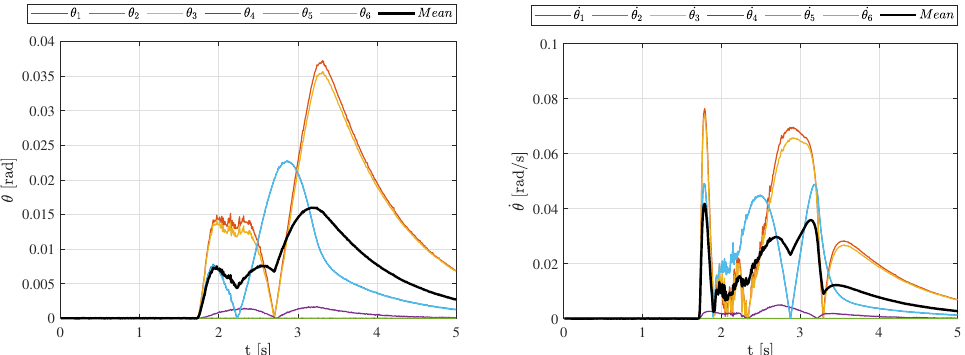
Figure 19. Test case 3, Mode II. The error between simulation and real system. Joint rotations ( left ) and joint speeds ( right ).